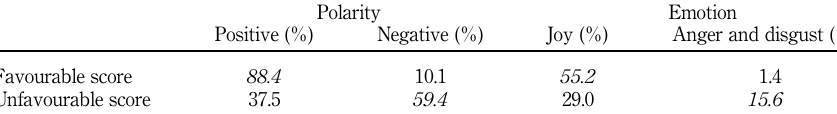
Polarity Emotion Positive (%) Negative (%) Joy (%) Anger and disgust (%) Favourable score 88.4 10.1 55.2 1.4 Table IV. Unfavourable score 37.5 59.4 29.0 15.6 Frequency of comments according to polarity and emotion by type of